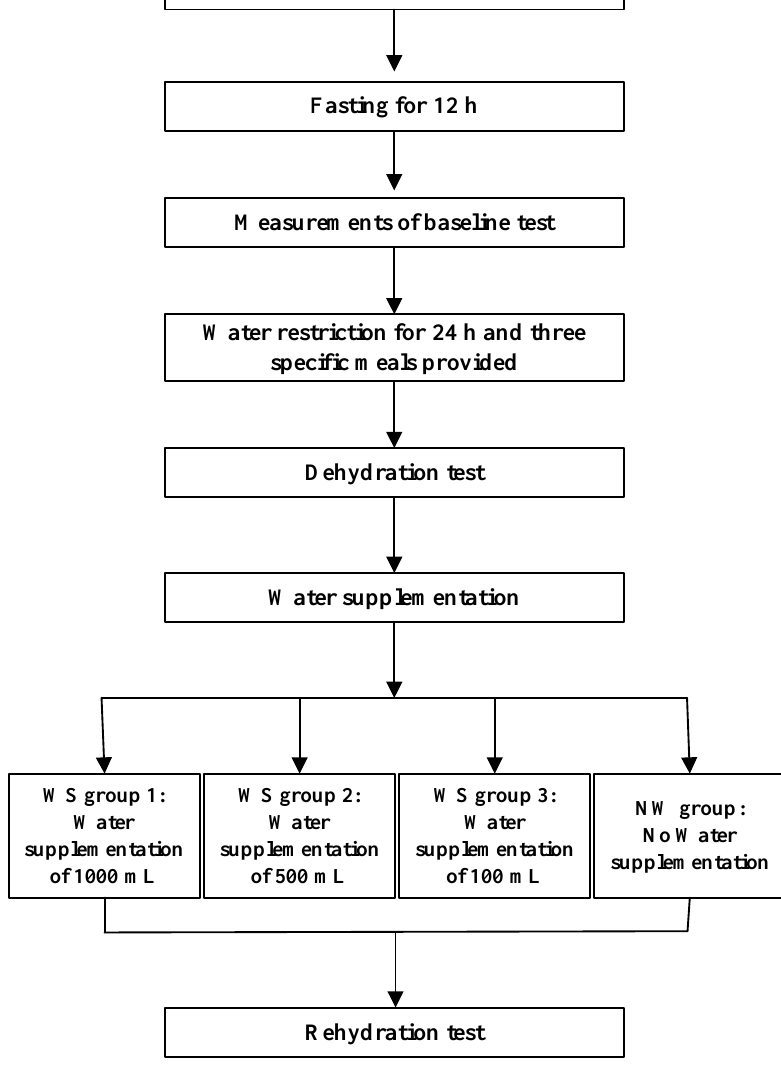
Figure 1. Study design.